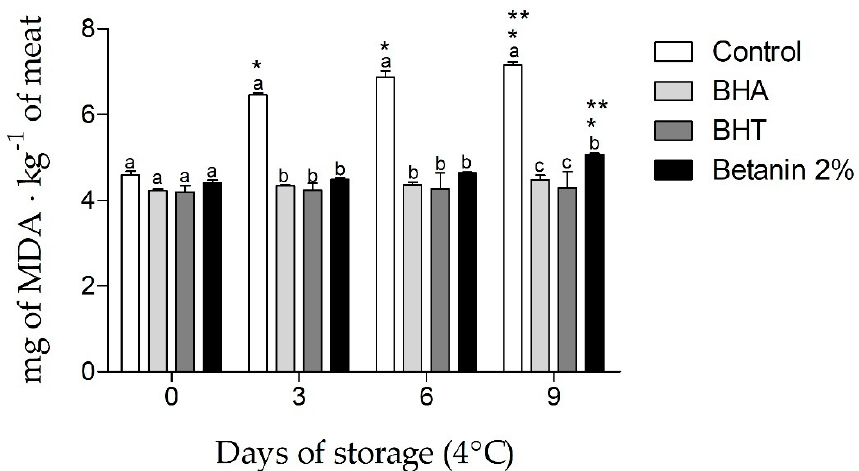
Figure 3. Lipid oxidation in ground pork loin evaluated by the production of malondialdehyde (MDA) during 9 days of storage at 4 ◦ C. Control H 2 O-DD, BHA (buthylated hydroxyanisole), BHT (butylated hydroxytoluene), Betanin 2% ( w / w ). Data are expressed as the means ± SD of three independent determinations. Different letters indicate differences between days at a significance level of p < 0.01. The symbol * ( p < 0.05) indicates differences compared to day 0. The symbol ** ( p < 0.05) indicates differences compared to day 3.